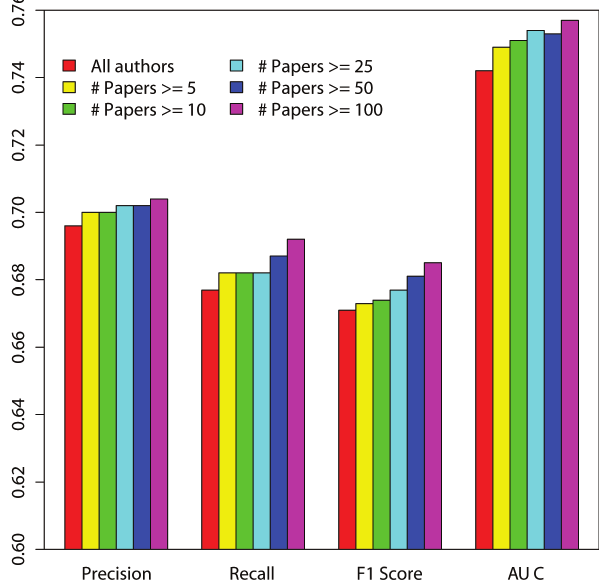
Figure 2. Test results of the SVM model (Authors with high productivity and less